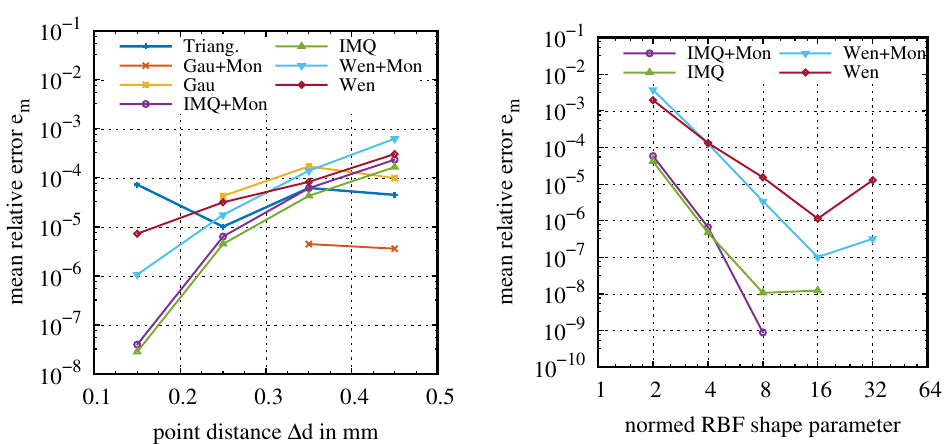
Figure 3. Mean relative error behavior e m , see Equation (37): ( left ) variation of point distance for constant shape parameter, ( right ) variation of shape parameter β W and β I for constant point distance ∆ d = 0.25mm.